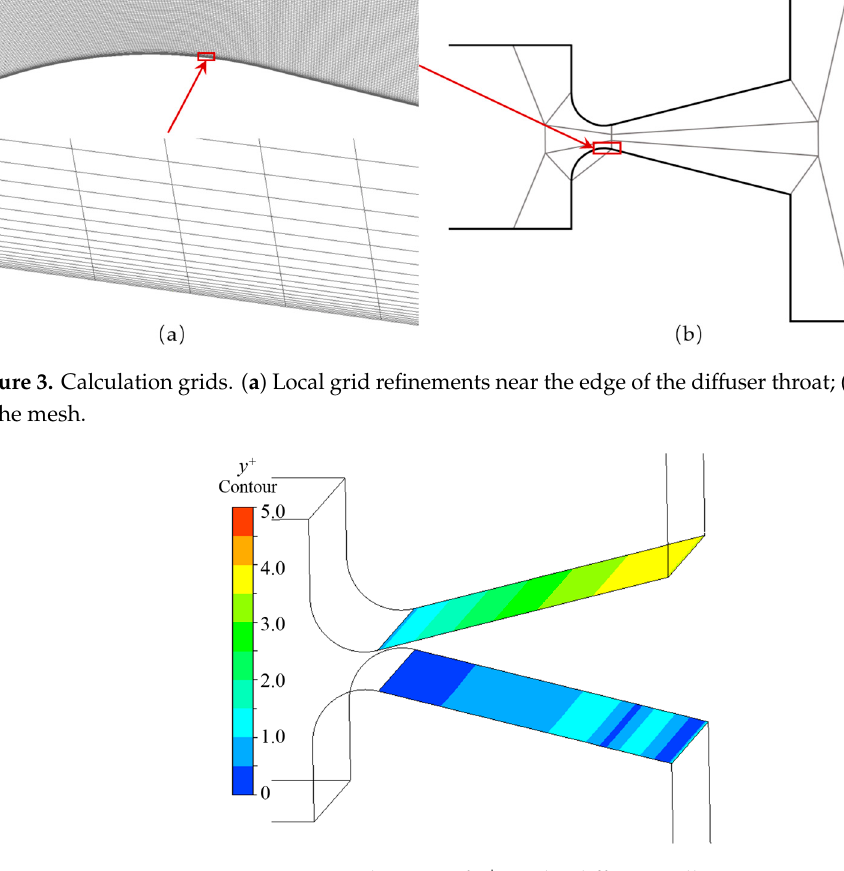
Figure 4. Distributions of y + on the diffuser walls.